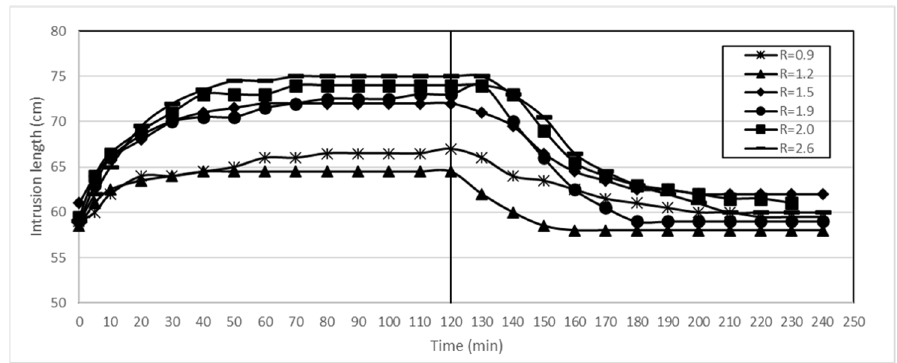
Figure 7. Change in intrusion lengths over time from the end of Step 2 to Step 4.